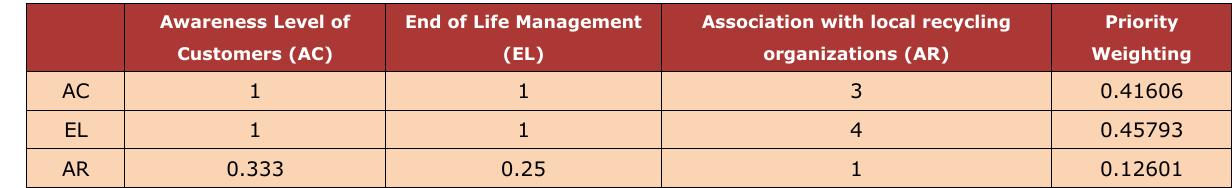
Table 6. Strategies of Upward stream supply chain members (Dimension